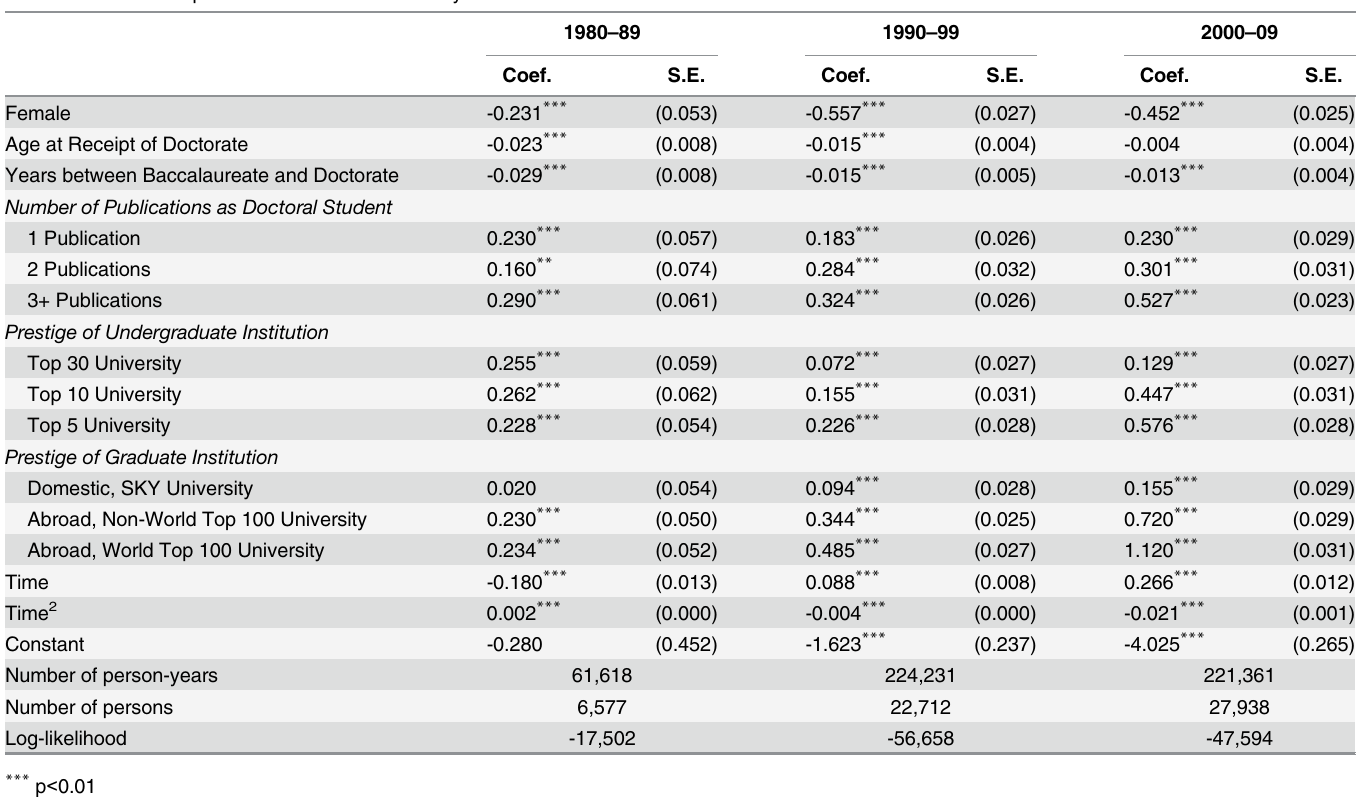
Table 2. Coefficients from the Logistic Regression Analysis of Timing of First Tenure-Track Academic Position on Selected Independent Vari- ables, by Doctoral Cohorts: Korea Researcher Information (KRI) Database, 1980 – 2009. Standard errors are in parentheses. For number of publications as a doctoral student, the omitted category is “ no publications ” ; for prestige of undergraduate institution, the omitted category is “ below top 30 university ” ; for prestige of graduate institution, the omitted category is “ domestic, non-SKY university. ” SKY universities also include KAIST and POSTECH. All models con- trol for academic discipline fixed-effects and current